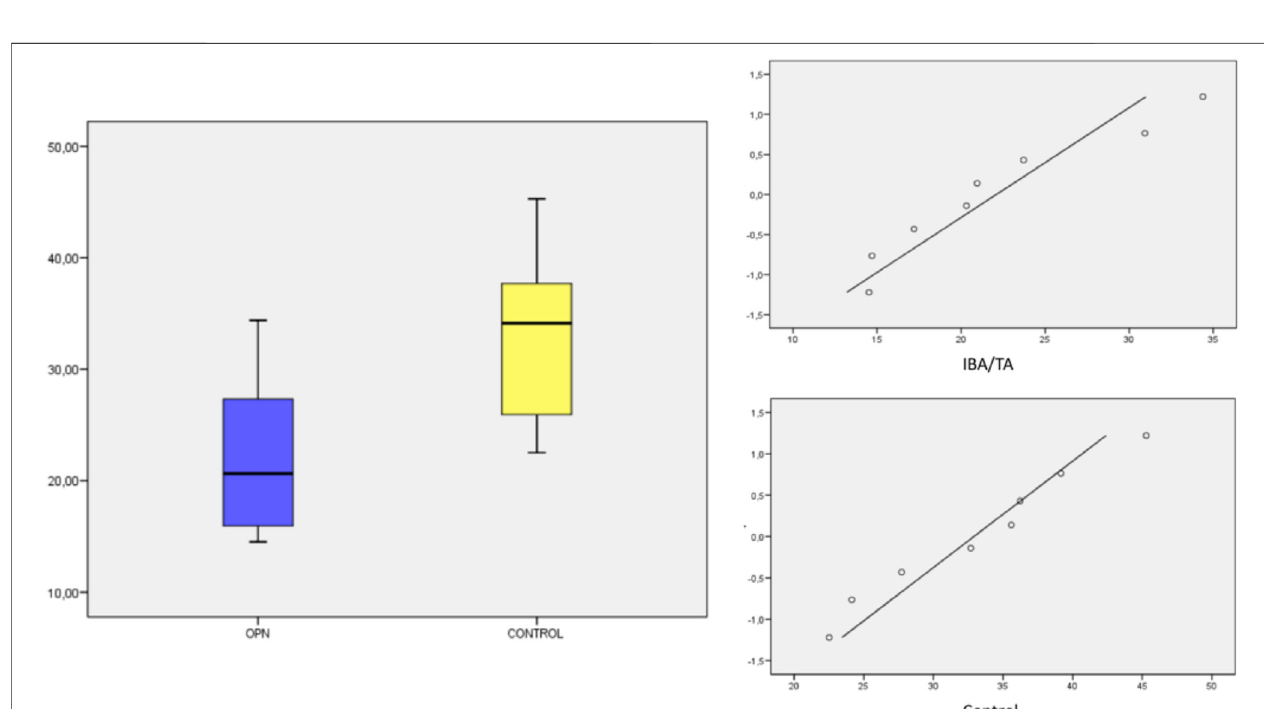
FIGURE 5 | Boxplot and Q-Q plot for